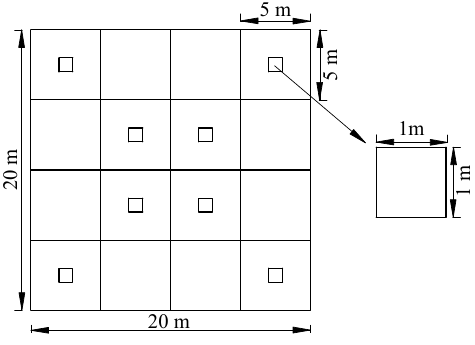
Figure 1. Quadrat layout for one sample plot.